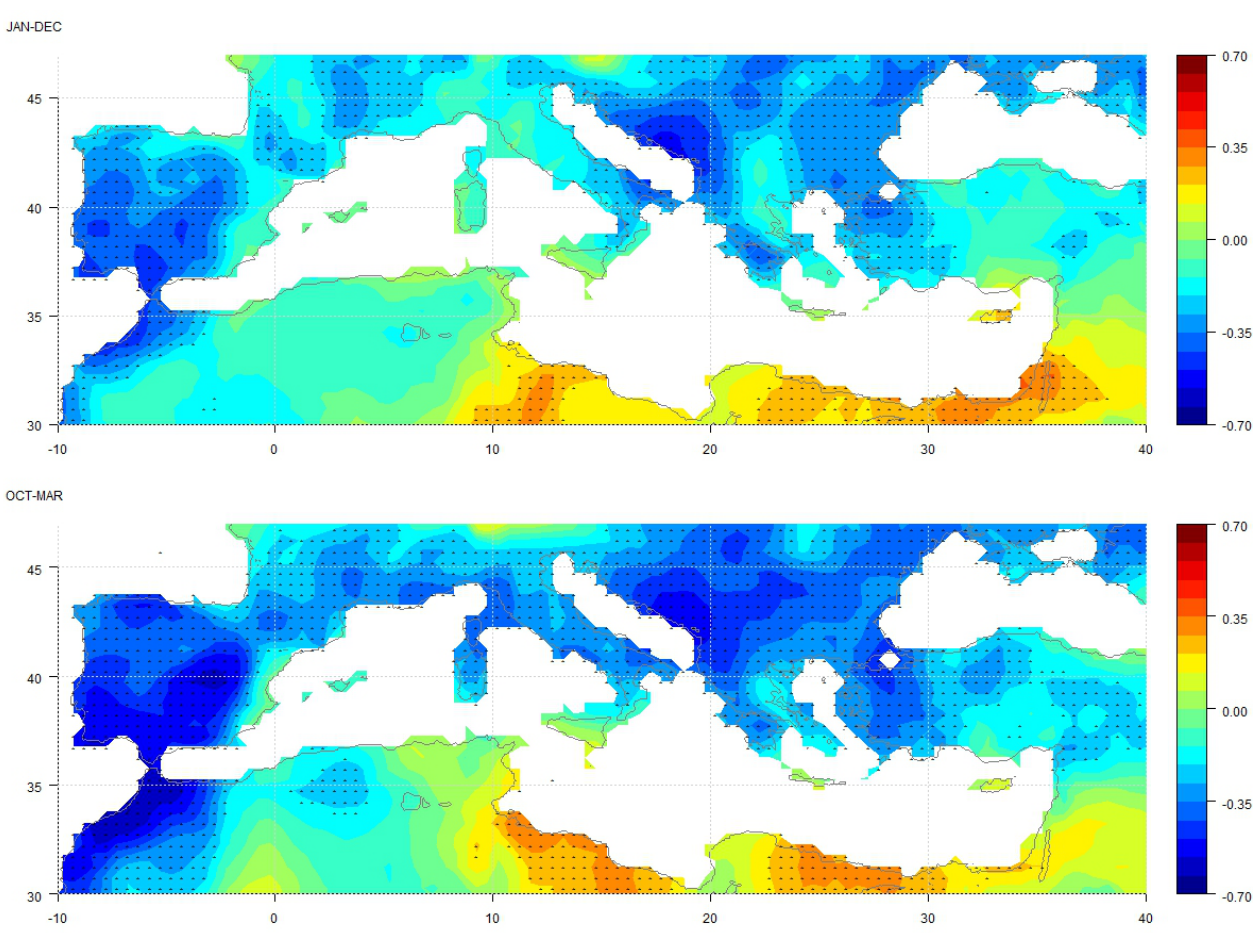
Fig. 7. Correlation coefficients between NAOI and gridded precipitation datasets (CRU TS 3.1) for the entire year (January–December, upper graph) and rainy season (October–March, lower graph). The asterisks denote statistically significant correlations (95% CL).